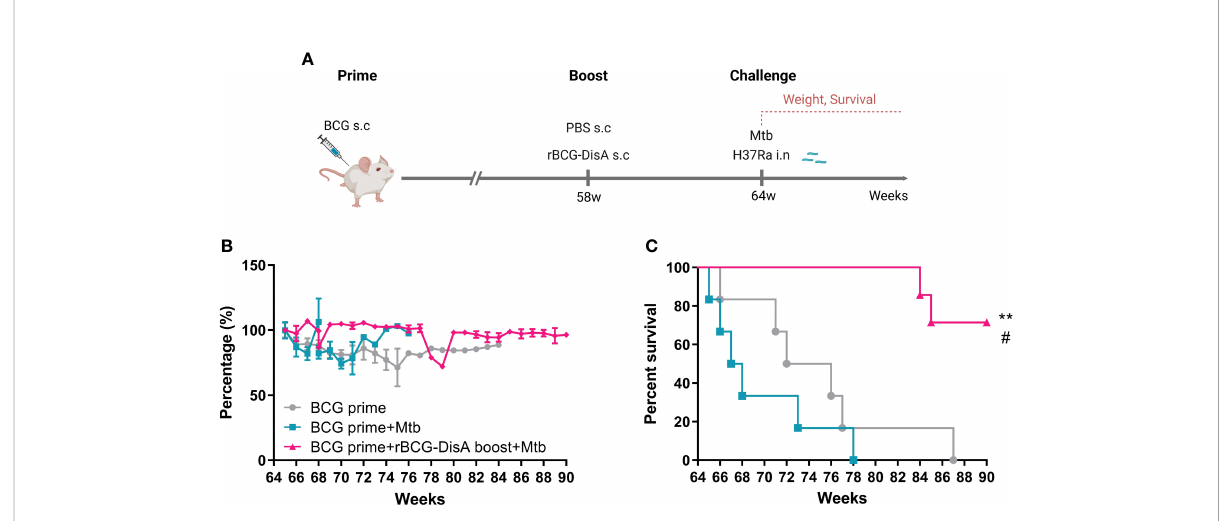
FIGURE 8 Body weight and survival in BCG prime following rBCG-DisA boost mice after M. tuberculosis infection. (A) BALB/c mice were primed by s.c BCG for 58-week following s.c rBCG-DisA boosting for 6-week. Subsequently, mice infected with M. tuberculosis by i.n route. Body weight and survival of mice were continuously monitored post M. tuberculosis infection. The schematic diagram of prime-boost strategy was created with BioRender.com. (B) Dynamic monitoring of mouse body weight at each week after M. tuberculosis infection. Results are presented as a percentage of body weight to initial body weight. (C) Survival of mice after M. tuberculosis infection ( n =5~6). (Panel C , ** P < 0.01 stands for rBCG-DisA boosting group v.s BCG primed group. # P < 0.05 stands for rBCG-DisA boosting group v.s and BCG primed+Mtb